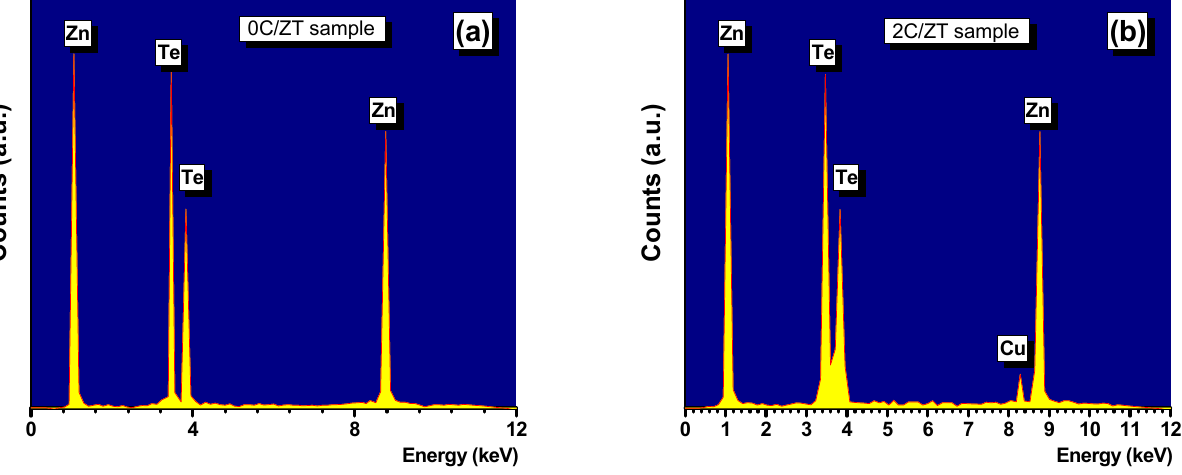
Figure 1. EDAX of ( a ) ZnTe and ( b ) Zn 0.98 Cu 0.02 Te thin films. Table 1. Weight percent and atomic percent for the undoped ZnTe and ZnTe:Cu obtained using